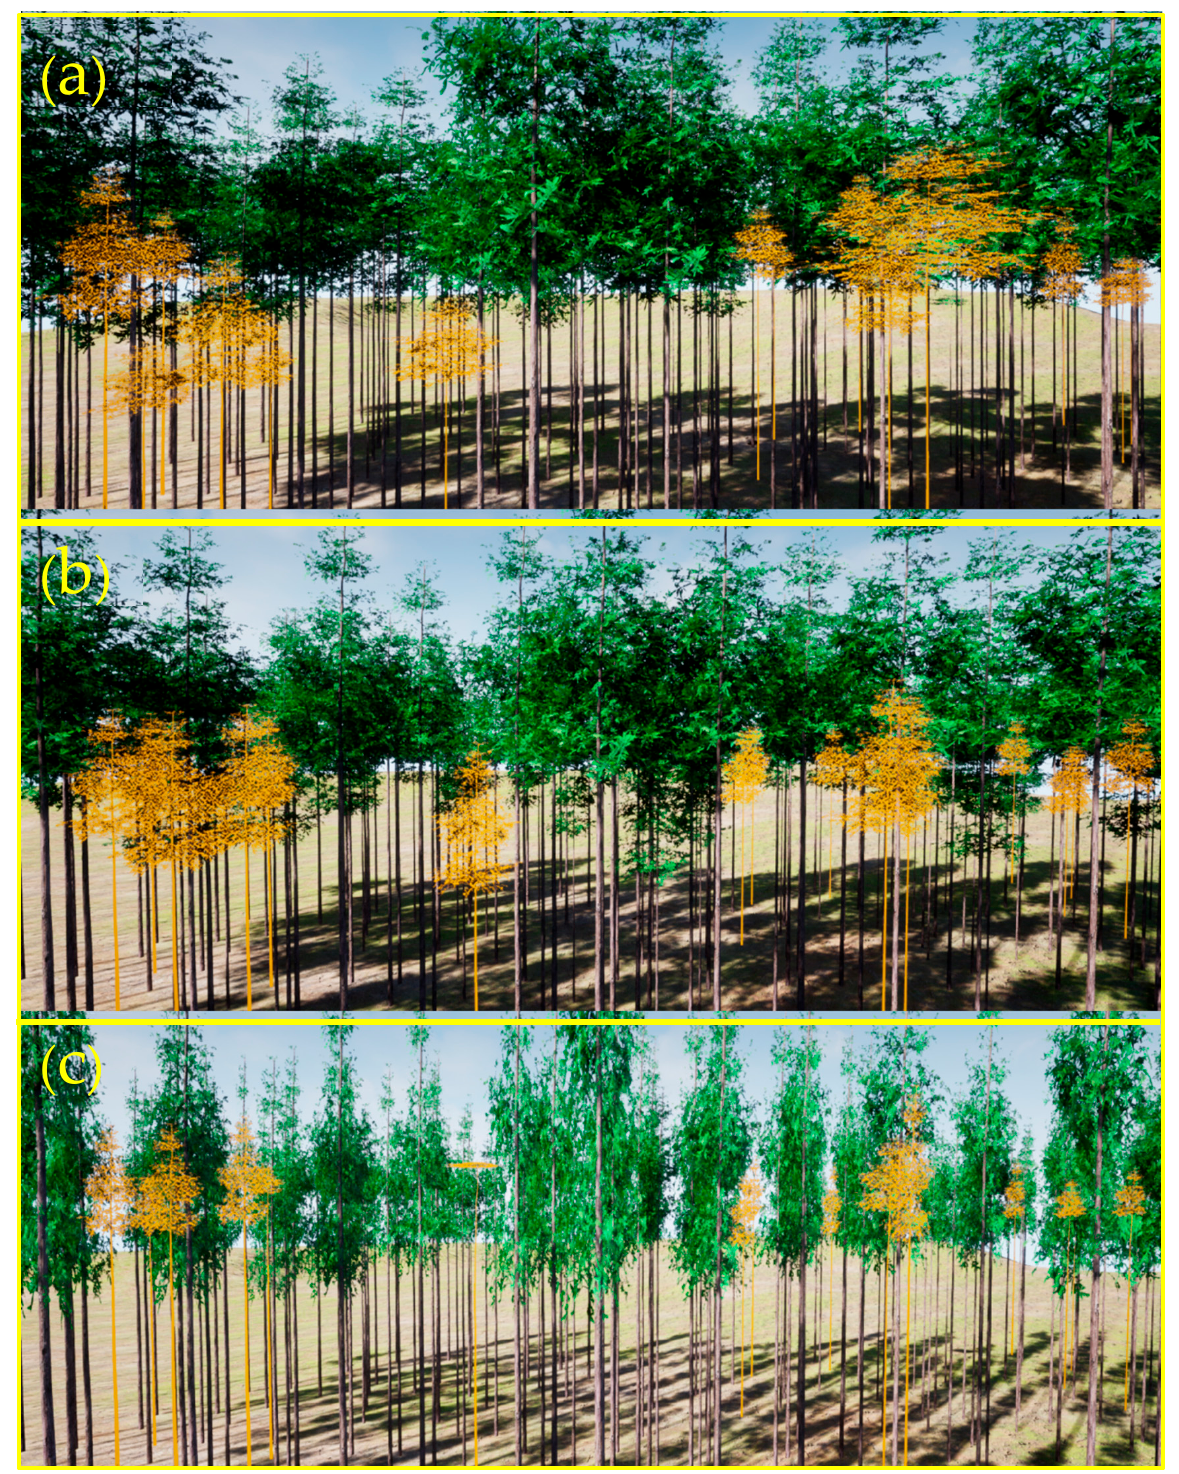
Figure 13. Visual simulation results of poor growth and growth space restricted trees (CGSS > 5) in 28-year-old Chinese fir stands. ( a ) Simulation by observed data; ( b ) Simulation by predicted data from CGMSS Chinese fir growth model; ( c ) Simulation by predicted data from SSU Chinese fir growth model. Highlighted trees in the fi gure are growth-limited Chinese fi r trees.